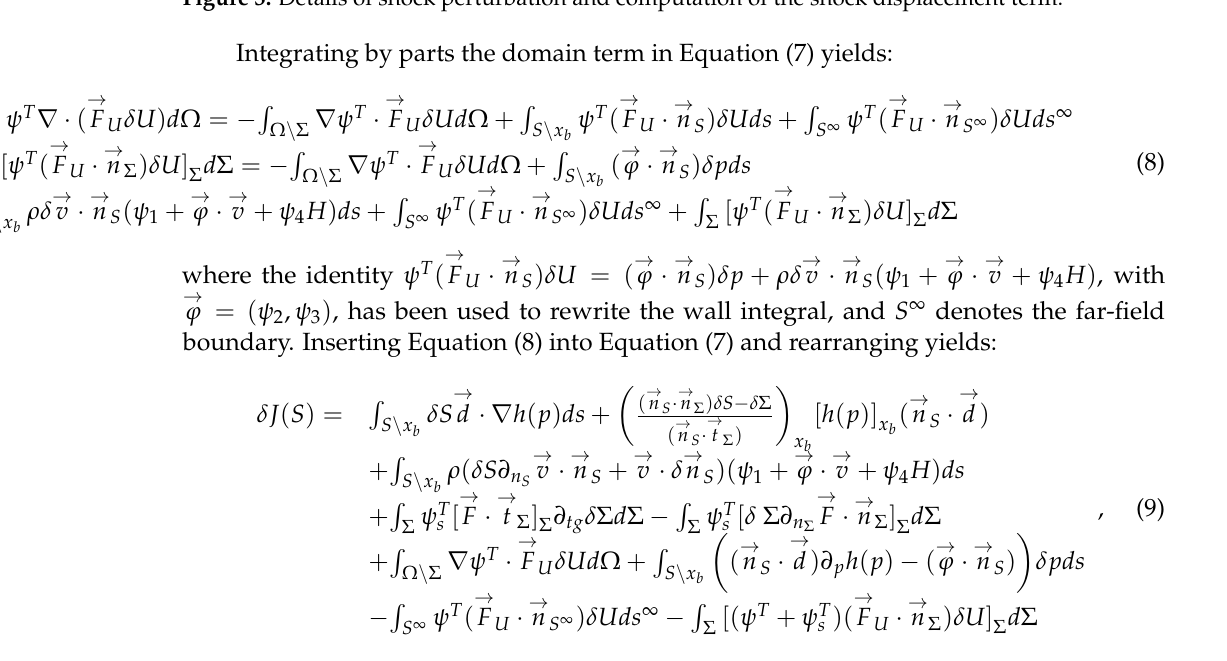
Figure 3. Details of shock perturbation and computation of the shock displacement term.